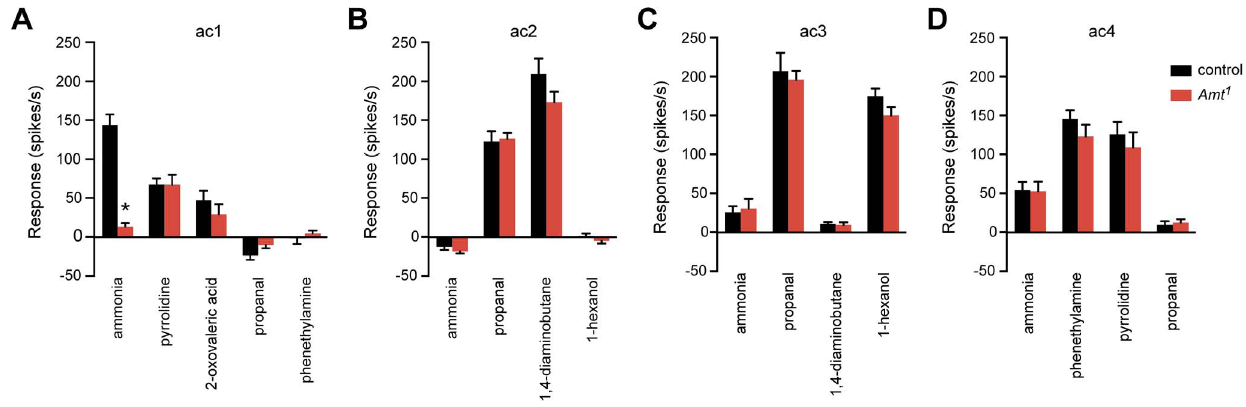
Figure 7. The Amt 1 defect is restricted to the ammonia response of ac1 sensilla. (A) Odor responses of ac1 sensilla in Amt 1 . Ammonia, 2- oxovaleric acid, and pyrrolidine each activate one of the three ORNs in ac1; only the ammonia response was impaired (n=10–11, p , 0.0001). (B–D) Response profiles of other sensillar types appeared normal (n=8–9 each).